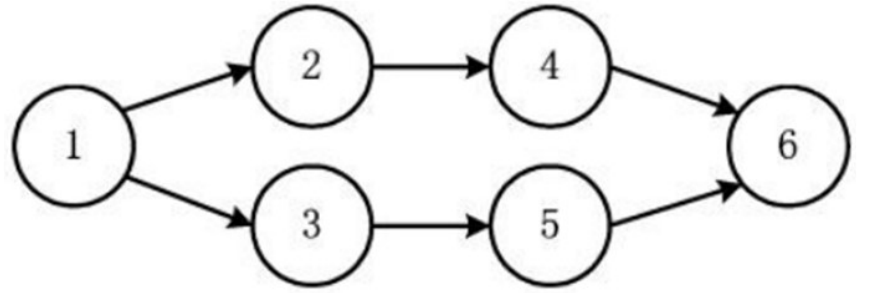
Figure 2. Workflow. Table 2. Task load and data